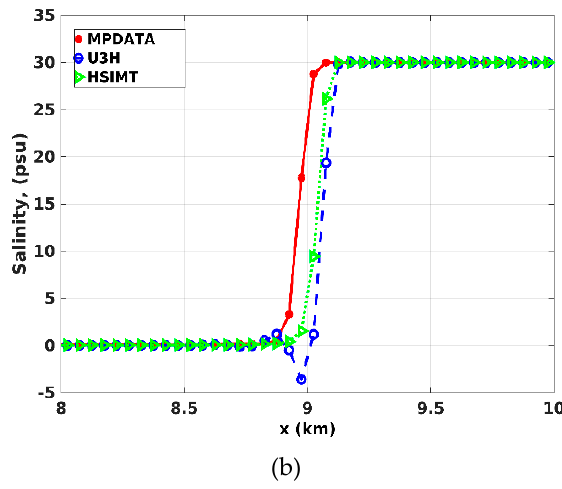
Figure 5. Test Case 3: Lock exchange using the MPDATA scheme with a ∆ x of 50 m; ( a ) Comparing numerical mixing distribution with contour levels of salinity (15 psu isohaline) using different tracer advection schemes ( b ) Salinity profile at 1.25 m depth at the end of simulation (2.2 h).